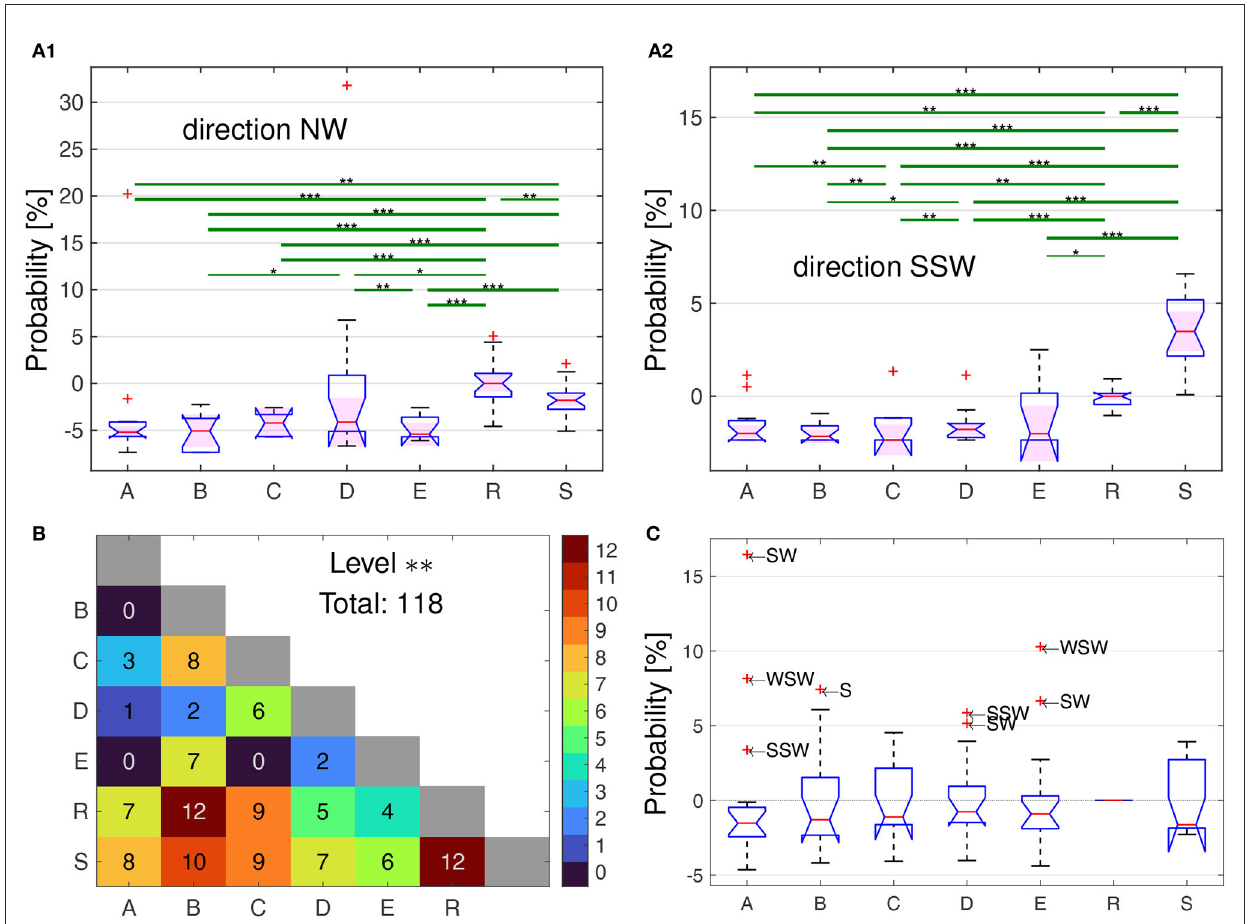
FIGURE4 Relative proportions of flight directions for the bees from the five home areas (A–E) and the simulated bees in the models R and S. (A1 , A2) Statistical analyzes of the directional frequencies, at the example of directions NW (A1) and SSW (A2) . The boxplots show the distribution of the relative time each bee within its group spent in the sector NW or SSW, respectively, additively normalized by the median of the R bees, i.e., 0% means the same probability as the median of the R bees, 5% means 5% more time in that sector. The ordinates are scaled differently due to two extreme outliers in the NW-direction. Significant differences between groups of bees are shown by the green lines, with * corresponding the a difference of Measures of Effect Size based on Cohen’s U3 test for two samples ( ∆ mes) of at least 0 . 2, while ** for ∆ mes 0.3, and *** for ∆ mes 0.4 up to the maximal ≥ ≥ difference of 0 . 5. Two examples are shown here, with the full set of results in Supplementary Data Sheet S2. (B) Total number of significant differences among the 16 directions for each pair of groups, with ∆ mes 0.3 (which corresponds to **), the number is also color coded according ≥ to the colorbar on the right. In total, there are 118 cases where a direction can be used to used to discriminate two groups with ∆ mes 0.3, i.e., ≥ significance level **. (C) Boxplots of the distribution of the median relative time the bees of each group spent in each of the 16-wind compass directions [see (A1) and (A2) for two examples], additively normalized by the corresponding value of the R bees. Thus, all probabilities are zero for the R bees, while e.g., a positive value of 5% correspond to directions in which at least half of the bees of a group spent 5% more time than half of the R bees in that direction. All outliers ( ) are labeled with the abbreviated direction they +